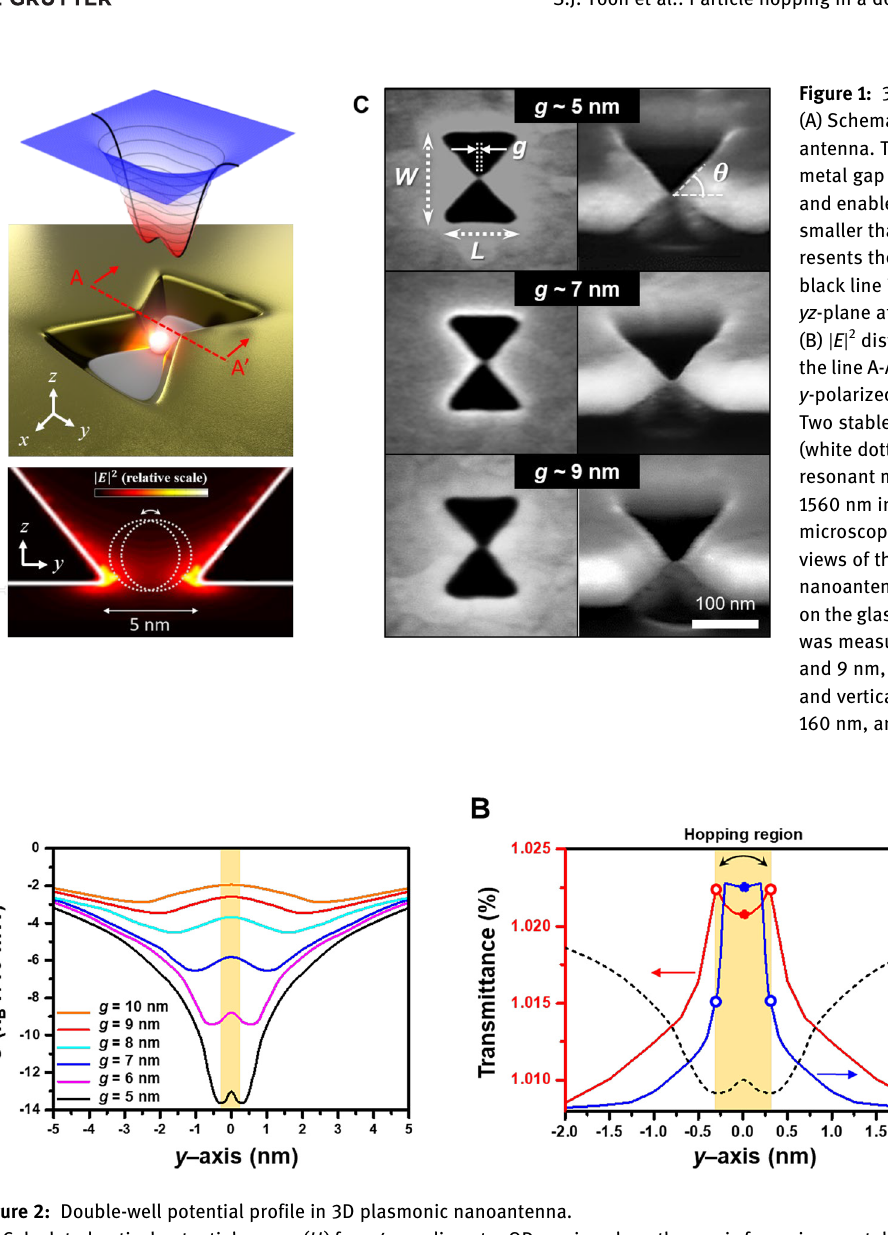
Figure 2: Double-well potential profile in 3D plasmonic nanoantenna. (A) Calculated optical potential energy ( U ) for a 4-nm-diameter QD moving along the y -axis for various metal gap sizes. Here, the incident CW laser power was 10 mW. The yellow area represents the hopping region of a nanoparticle in a 5-nm-gap nanoantenna. (B) Transmittance (red solidline)andelectric fi eldintensityenhancement(bluesolidline)asafunctionoftheQDpositionfora5-nm-gapnanoantenna.Ablackdotted line is the potential pro fi le.